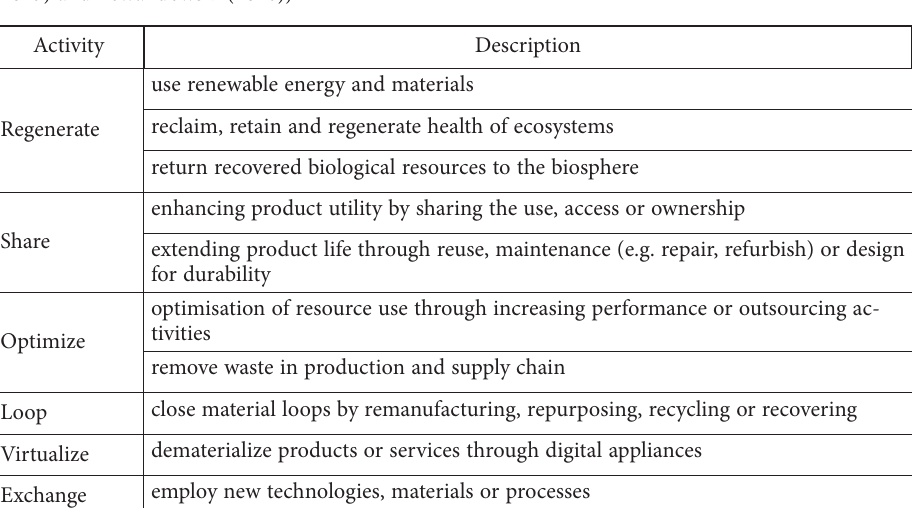
Table 1. The modified ReSOLVE framework (source: self-made based on Ellen MacArthur Foundation (2013) and Lewandowski